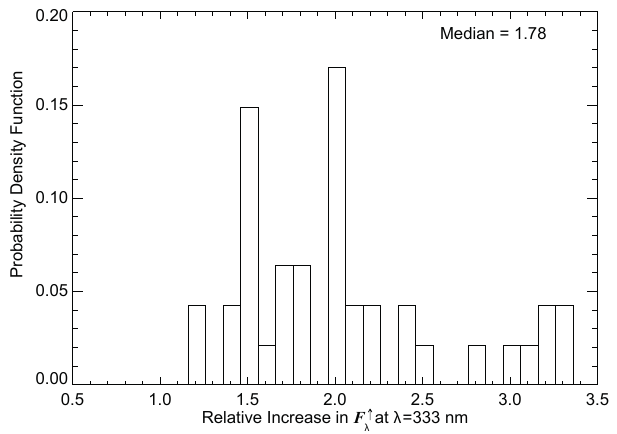
Figure 9. Probability density function of the relative increase in measured irradiance at 333nm above the individual cloud compared to a background value without cloud for all NPF events during April 2011.